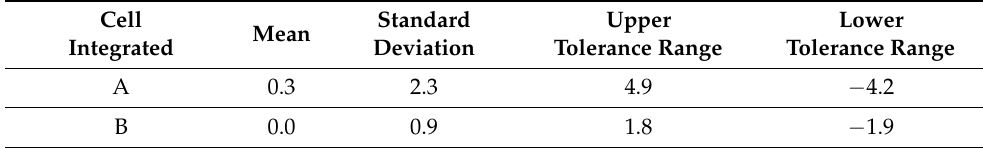
Table 6. Statistical analysis of the error distribution for Concept Z.